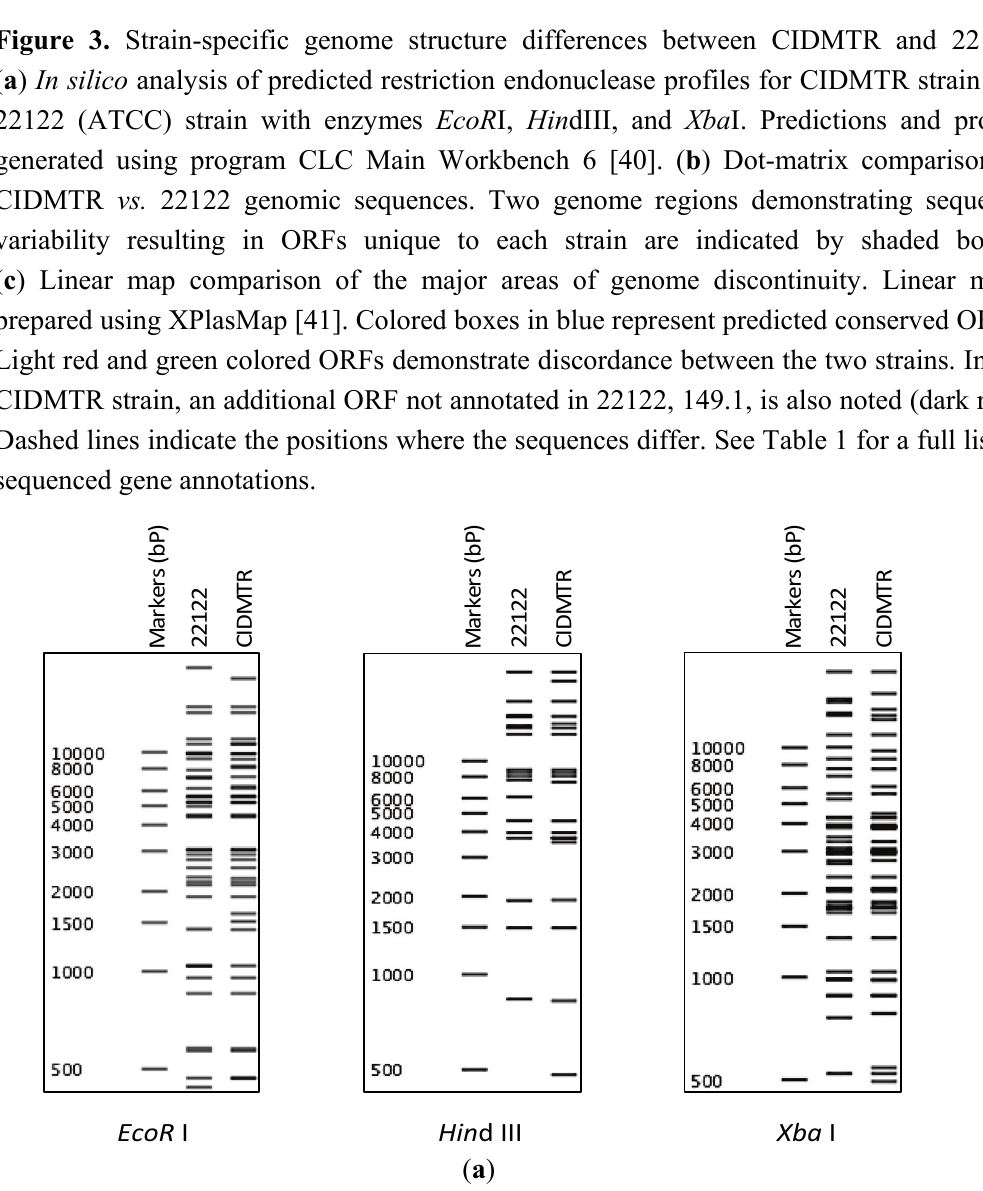
Figure 3. Strain-specific genome structure differences between CIDMTR and